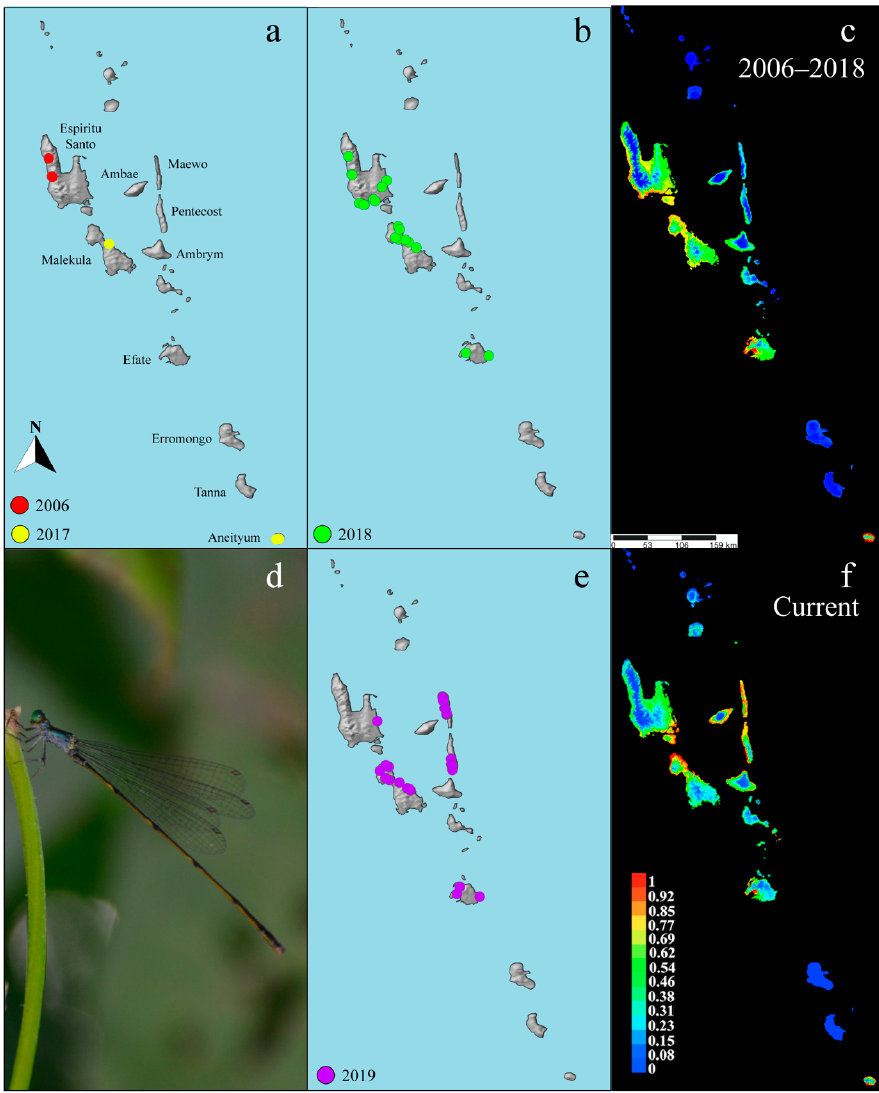
Figure 1. ( a ) Collecting localities pre-2018 used in the first model including data from 2006 and 2017; ( b ) Collecting localities from 2018 used in the first model; ( c ) First ecological niche model produced in MaxEnt using data from 2006–2018; ( d ) undescribed male Vanuatubasis from Efate; ( e ) collecting localities added to the model from 2019 fieldwork; ( f ) updated ecological niche model produced in MaxEnt with all